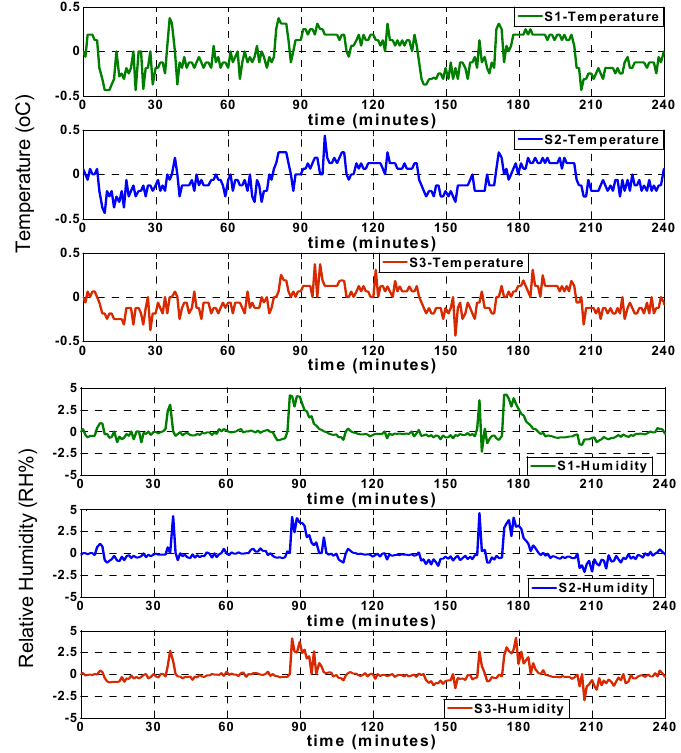
Figure 7. Approximation residual of each sensor